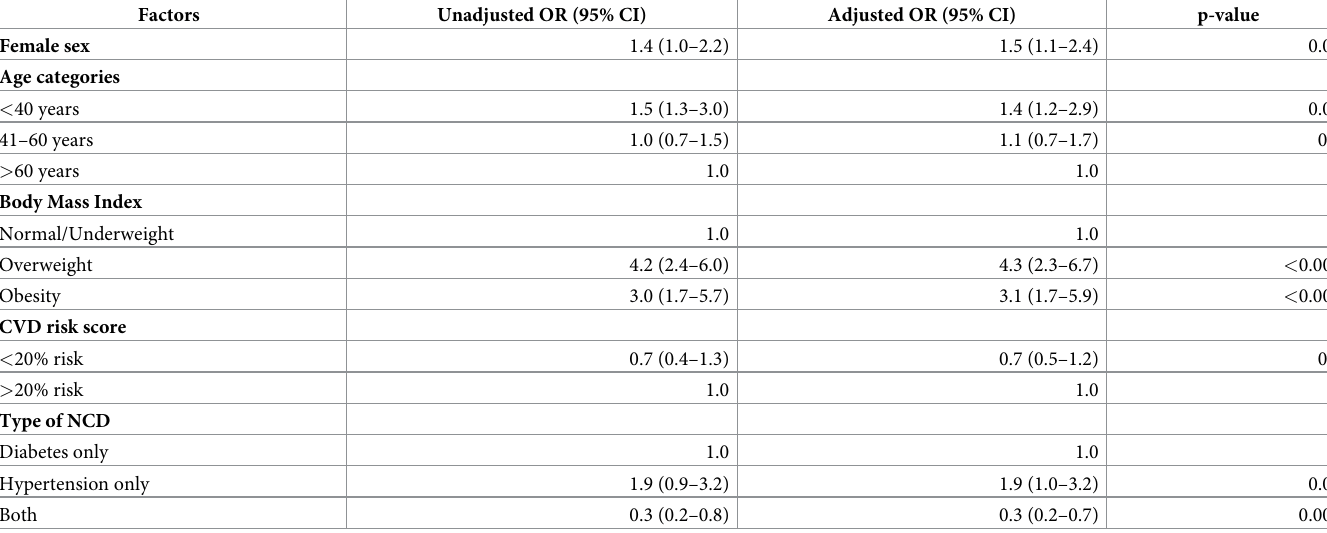
Table 7. Factors associated with loss to follow up among patients registered at PEN implementing facilities in Myanmar in 2017–18 (N =